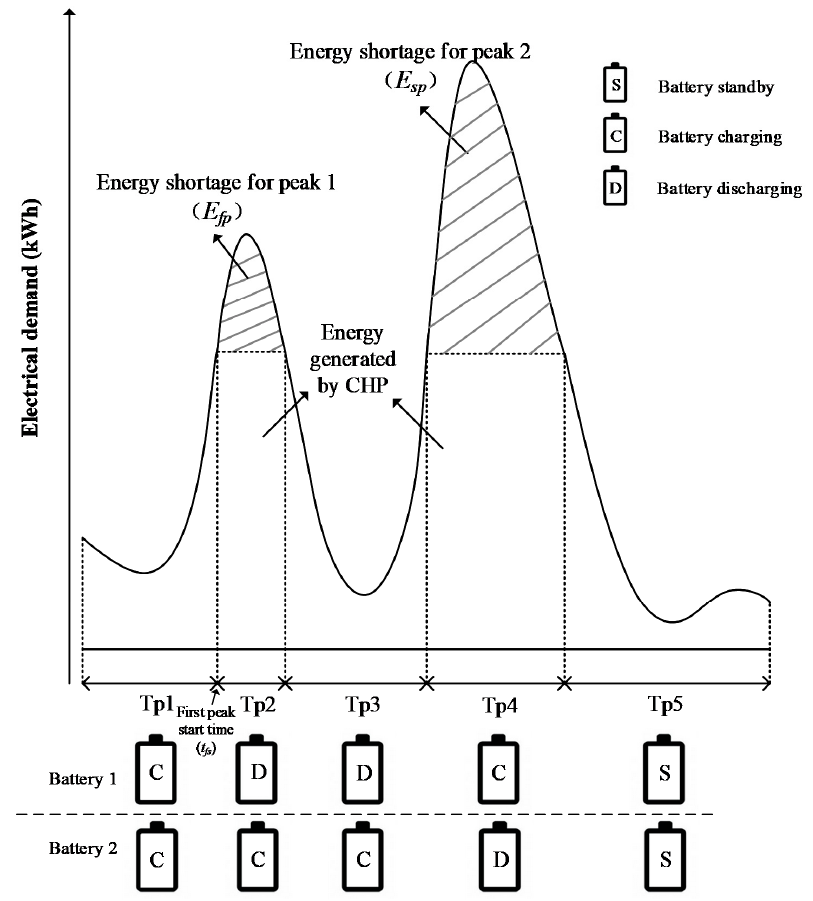
Figure 4. Two-battery storage system control rule.